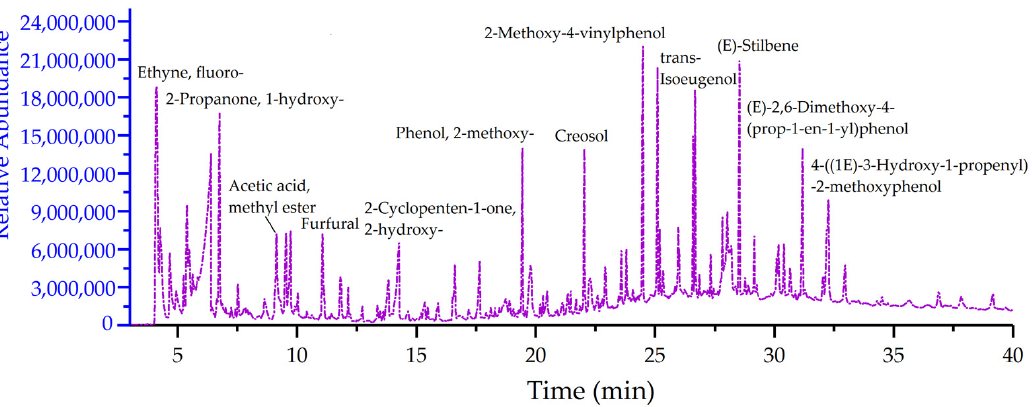
Figure 4. The total ion chromatography of S. holocarpa wood was determined by Py/GC–MS.